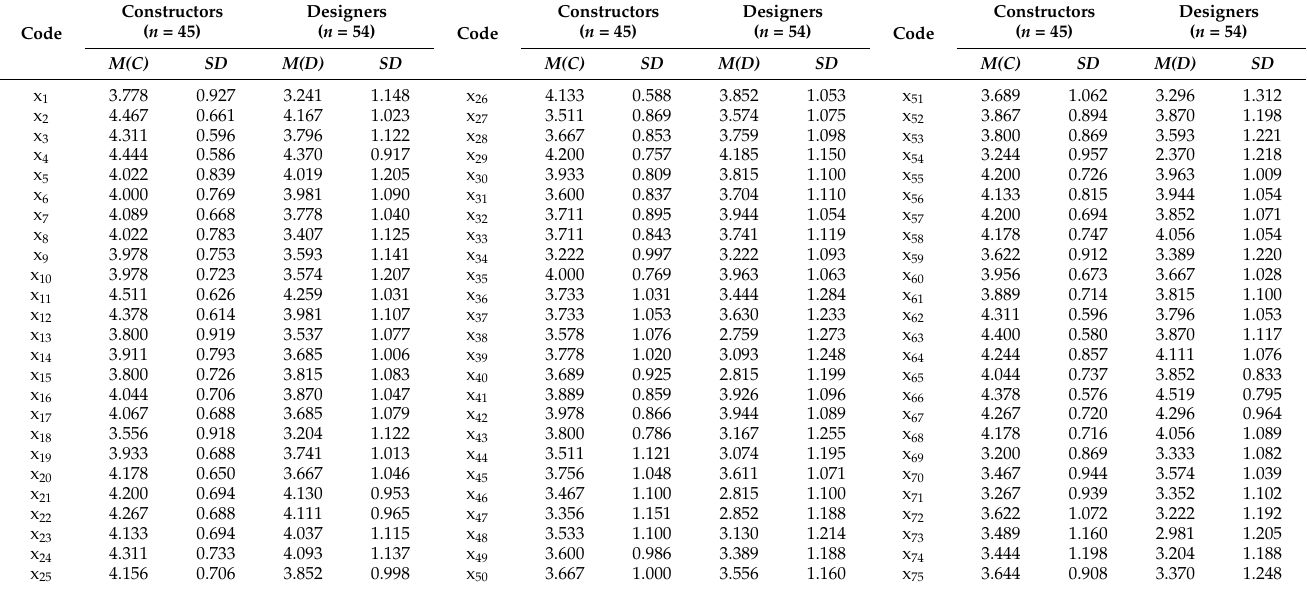
Table 8. Mean and variance of the preliminary